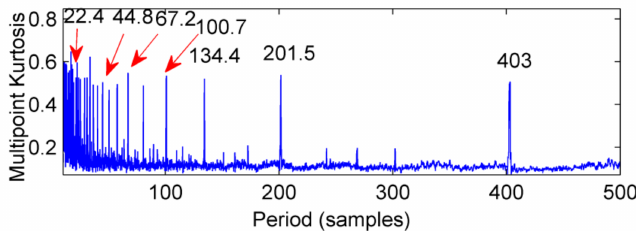
Figure 18. Multi-point simulation of healthy gearboxes.